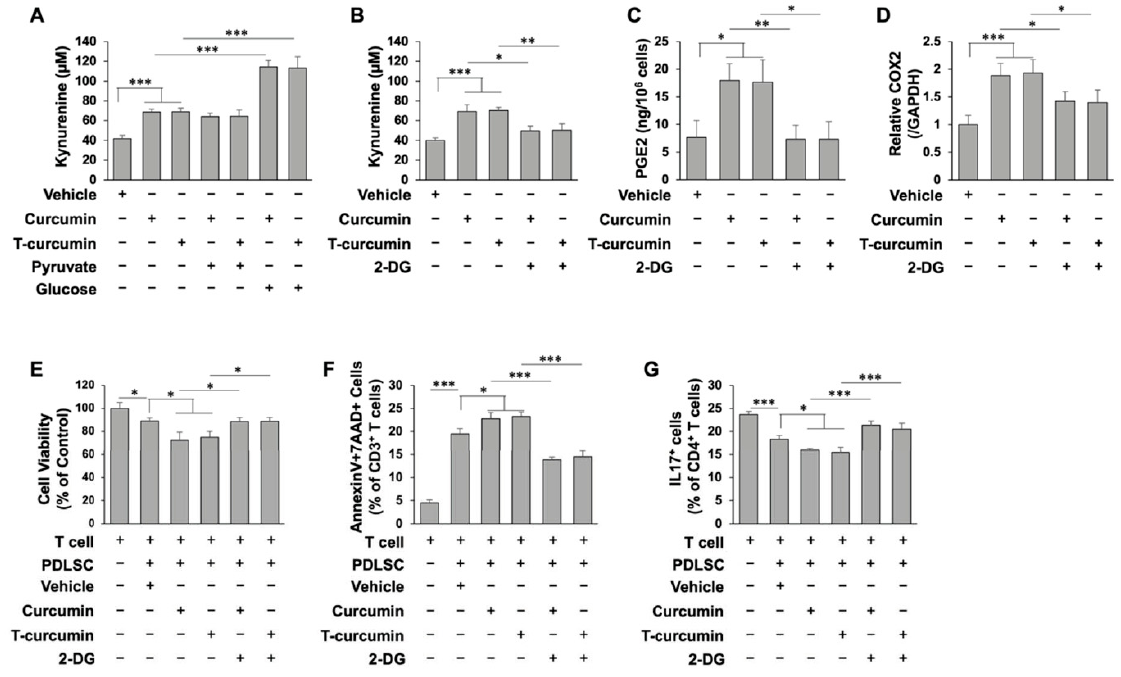
Figure 5. Glycolysis is required for PGE2/IDO secretion in PDLSC immunomodulation with curcumin treatment. ( A ) Production of kynurenine was significantly increased in curcumin treated PDLSCs. Addition of glucose, but not pyruvate, significantly increased kynurenine levels in curcumin treated PDLSCs. ( B ) IDO activity with or without glycolytic inhibitor, 2-DG treatment in the presence of curcumin in PDLSCs. ( C ) PGE2 level in cell culture supernatant with or without 2-DG treatment in the presence of curcumin in PDLSCs. ( D ) qPCR analysis of COX2 mRNA level with or without 2-DG treatment in the presence of curcumin in PDLSCs. ( E ) Cell viability of activated T cells after co-cultured with PDLSCs with or without 2-DG treatment in the presence of curcumin. ( F ) PDLSCs induced annexinV + 7AAD + double positive apoptotic CD3 + T cells in a PDLSC/T-cell co-culture system in vitro. Curcumin treatment further increased annexinV + 7AAD + double positive apoptotic CD3 + T cells, while 2-DG largely blocked curcumin-induced immunomodulation of PDLSCs. ( G ) PDLSCs could inhibit CD4 + IL17 + Th17 differentiation in vitro. Curcumin treatment further diminished Th17 differentiation, whereas 2-DG significantly reduce the inhibitory effect of curcumin. Error bars represent the s.d. from the mean values. *** p < 0.005; ** p < 0.01; and * p < 0.05.